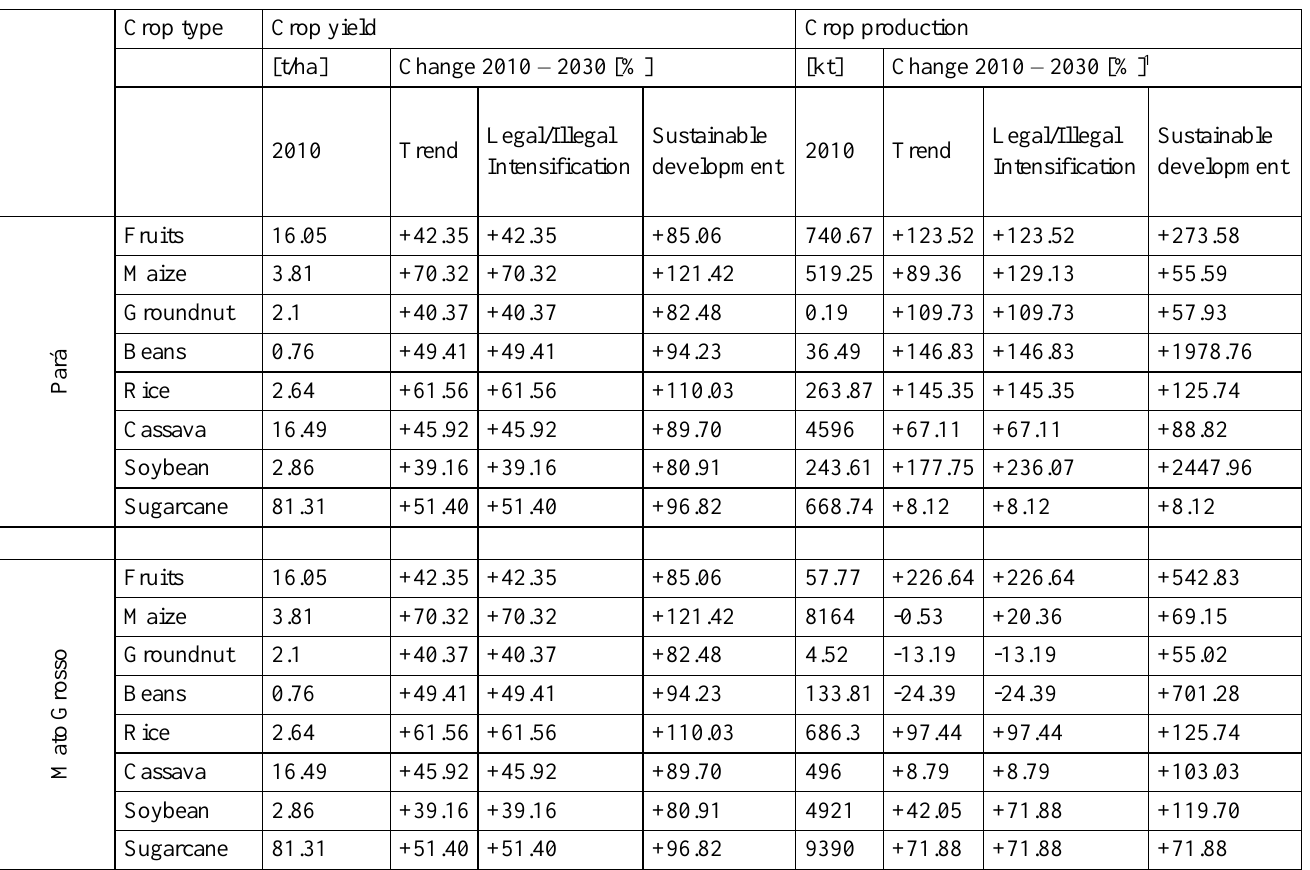
Table A1.6. Agricultural